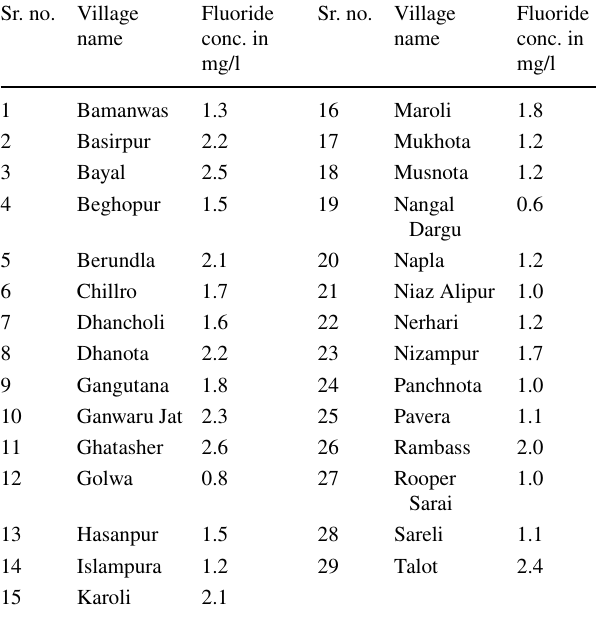
Table 7 Showing the average fluoride concentration in villages of